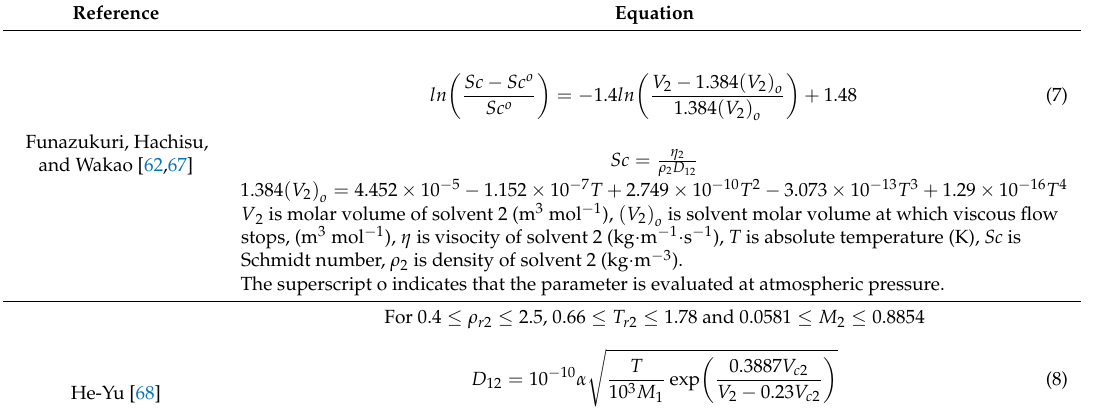
Table 2. Empirical correlations to predict diffusion coefficients for solutes in supercritical fluids at infinite